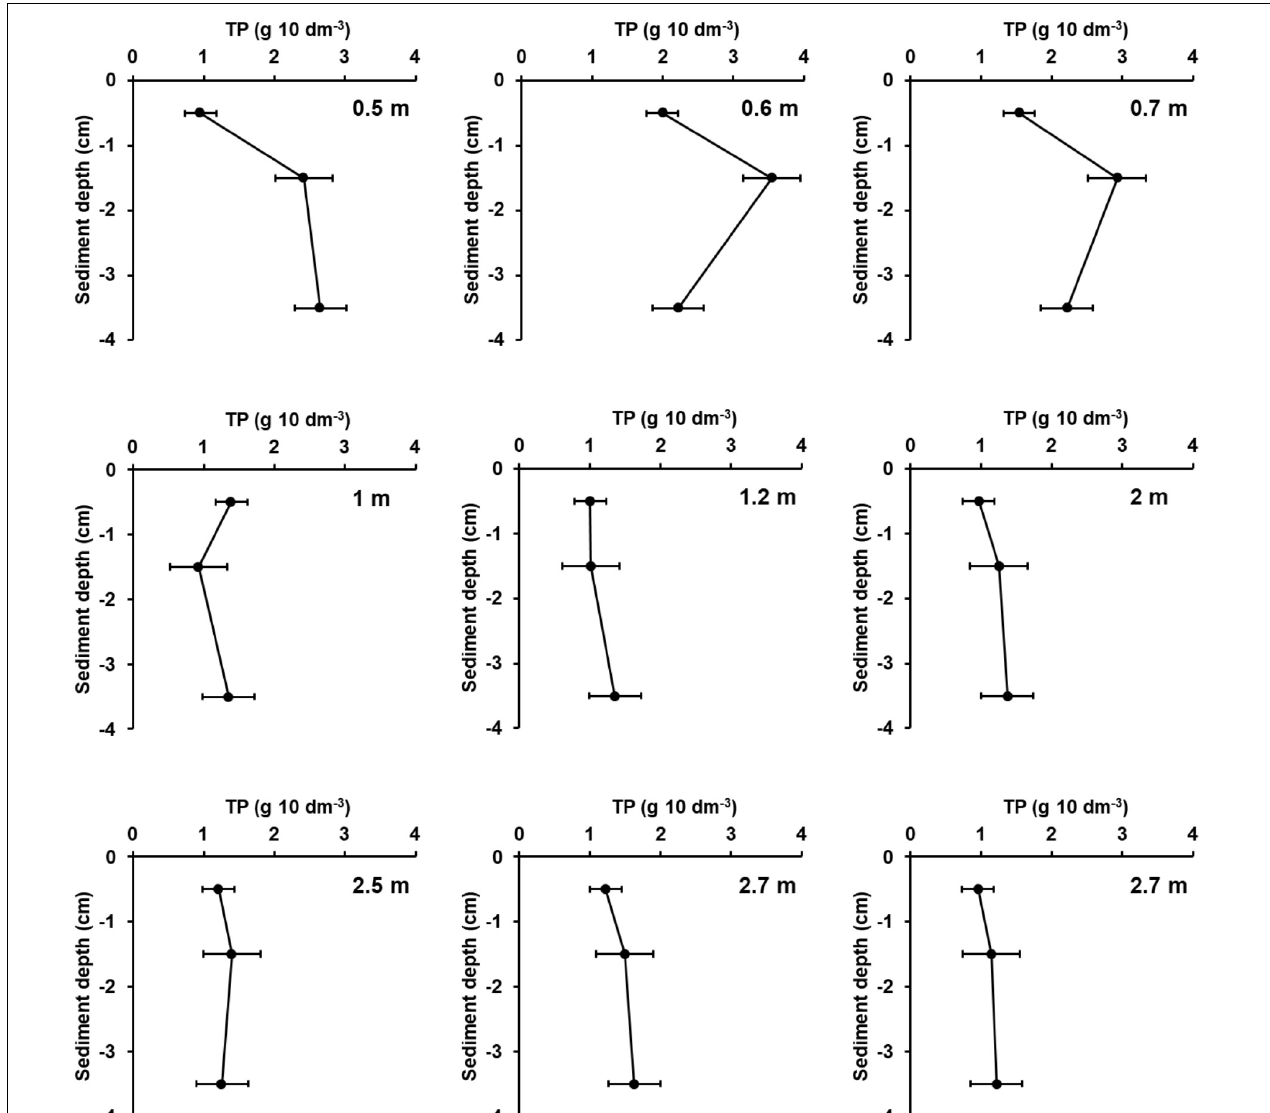
FIGURE 6 | Total phosphorus stocks (g TP 10 dm − 3 , 1 cm slices) within the upper 5 cm of sediment in Dabitz (Grabow). Sediment was sampled in a transect at nine stations and separated in three horizons, 0–1, 1–2, 2–5 cm. The horizon in 3.5 cm depth was a mixed sample of 2–5 cm. Water depth is shown within the diagrams. Station 8 and 9 are spatial separated but in the same water depth. Error bars are standard deviation of four measurement